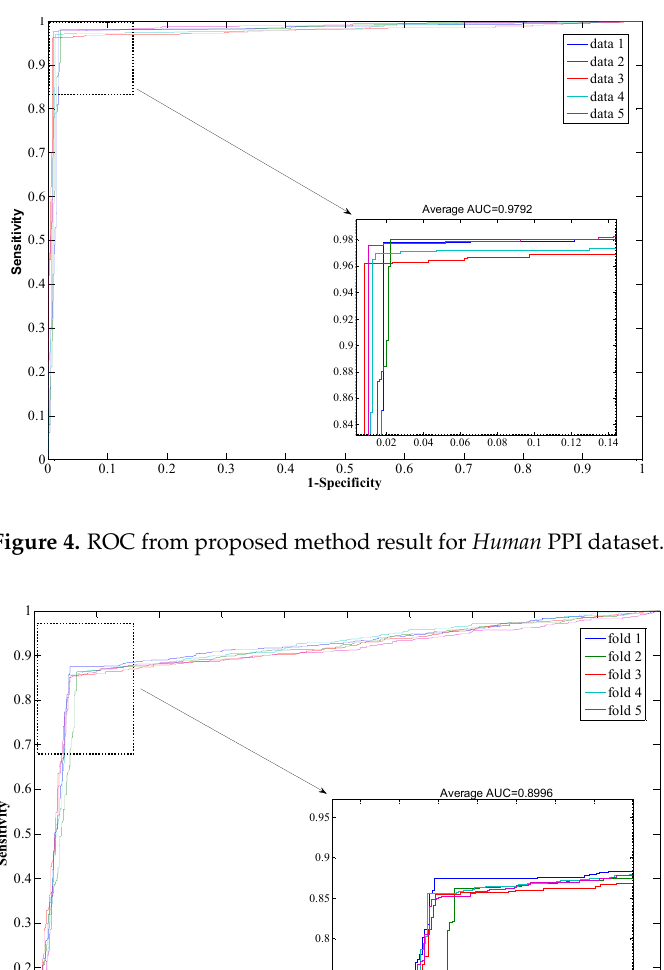
Table 4. Comparison of other methods on the S. cerevisiae dataset.